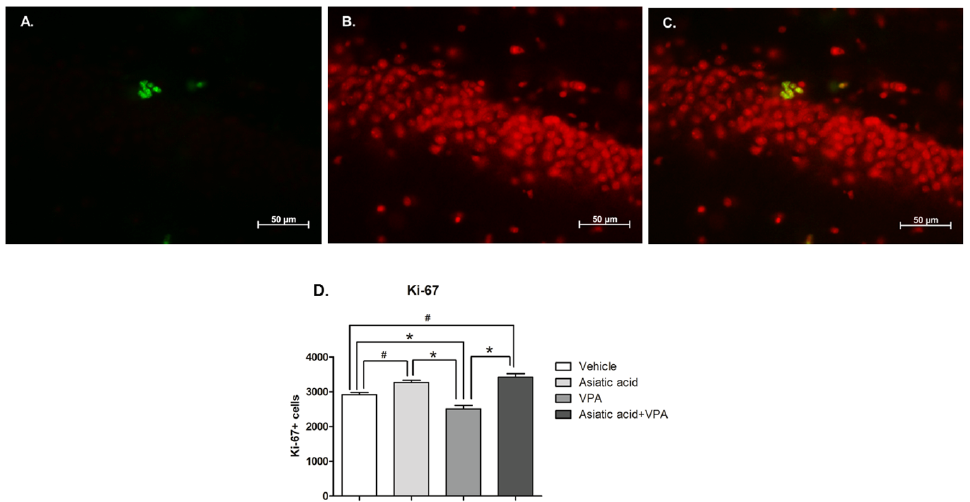
Figure 3. The number of Ki-67 positive cells in the SGZ of the hippocampal dentate gyrus. Ki-67 positive cells were stained in the SGZ of the dentate gyrus (green; ( A )). All nuclei were counterstained with propidium iodide (red; ( B ) and figure merged ( C )). The number of proliferating cells in animals receiving only VPA was significantly lower (* p < 0.05) than vehicle, Asiatic acid and Asiatic acid plus VPA groups, while Asiatic acid and Asiatic acid plus VPA groups were significantly higher when compared to the vehicle group (# p < 0.05). One ‐ way ANOVA with LSD post hoc test was used to compare between all groups ( D ). Nutrients 2016 , 8 , 303